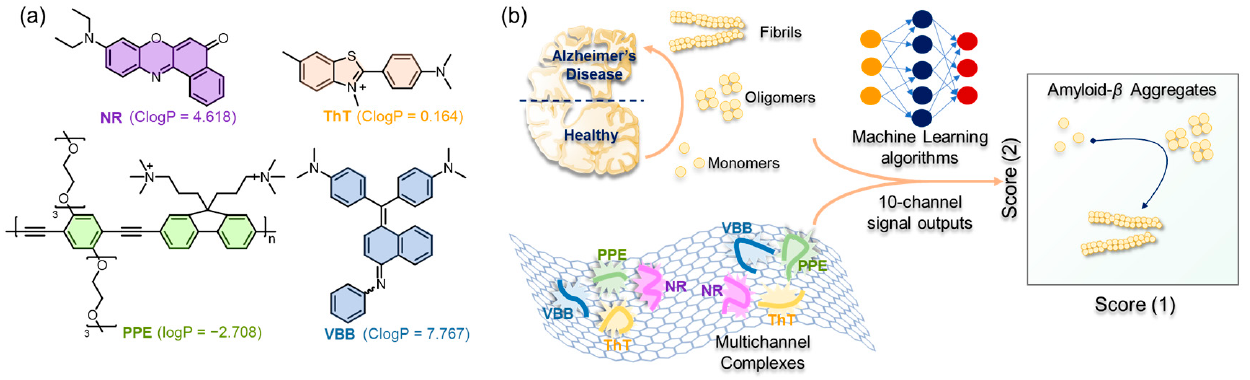
Figure 1. ( a ) Structure and ClogP (predicted by ChemBioDraw Ultra 18.0) of PPE, ThT, NR and VBB. ( b ) Schematic diagram of a multichannel sensor array for recognition of A β 40/A β 42 aggregates.